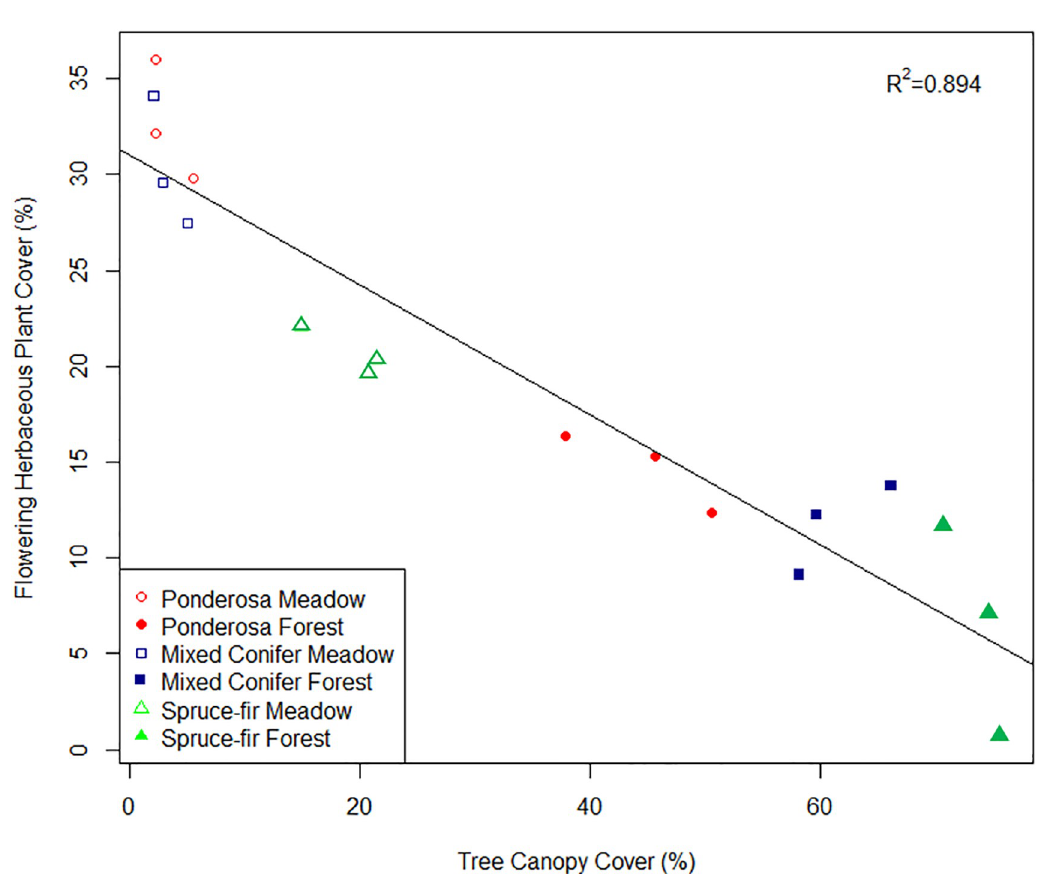
Fig 2. Change in flowering herbaceous plant cover relative to tree canopy cover in meadow (closed symbols) and forest habitats (open symbols). Symbols denote life zones means. As canopy cover increases flowering plant cover decreases ( f = 135.90 p < 0.001, R 2 = 0.894). While there is a range in floral resource at a low canopy cover, as canopy cover increases the amount of flowering plants becomes